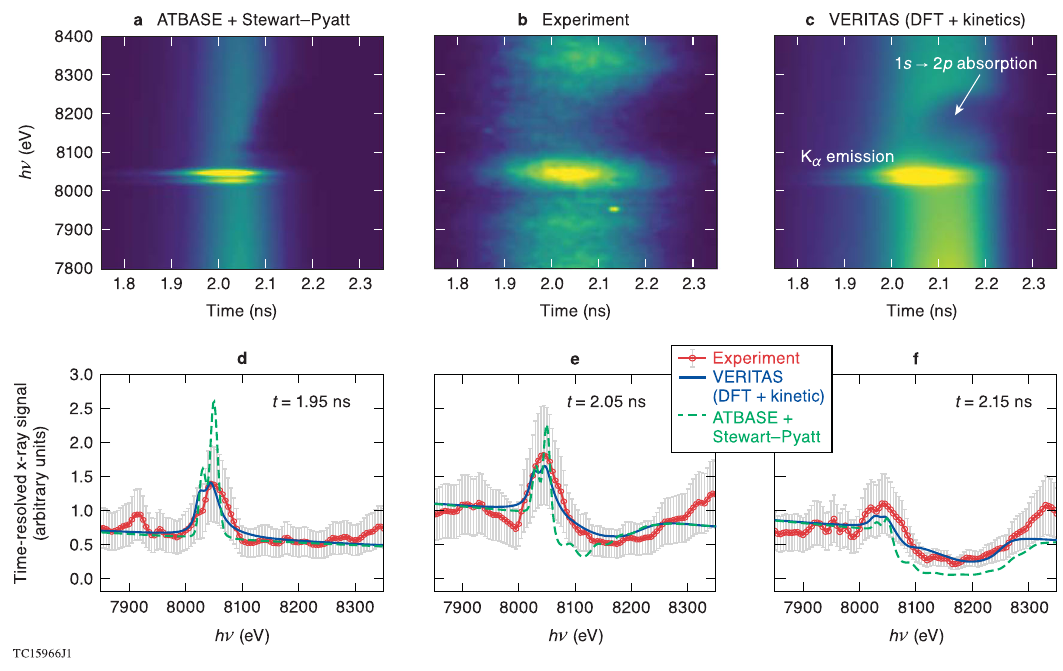
Fig. 4 | Comparison of time-resolved x-ray signals between experiment and modelsduringthecore fl ash.a Thestreaked spectrapredictedbytraditional CRE model ( Spect3D ) with isolated atomic database plus continuum-lowering (Stewart – Pyatt). b The experimental measurement. c The streaked spectra